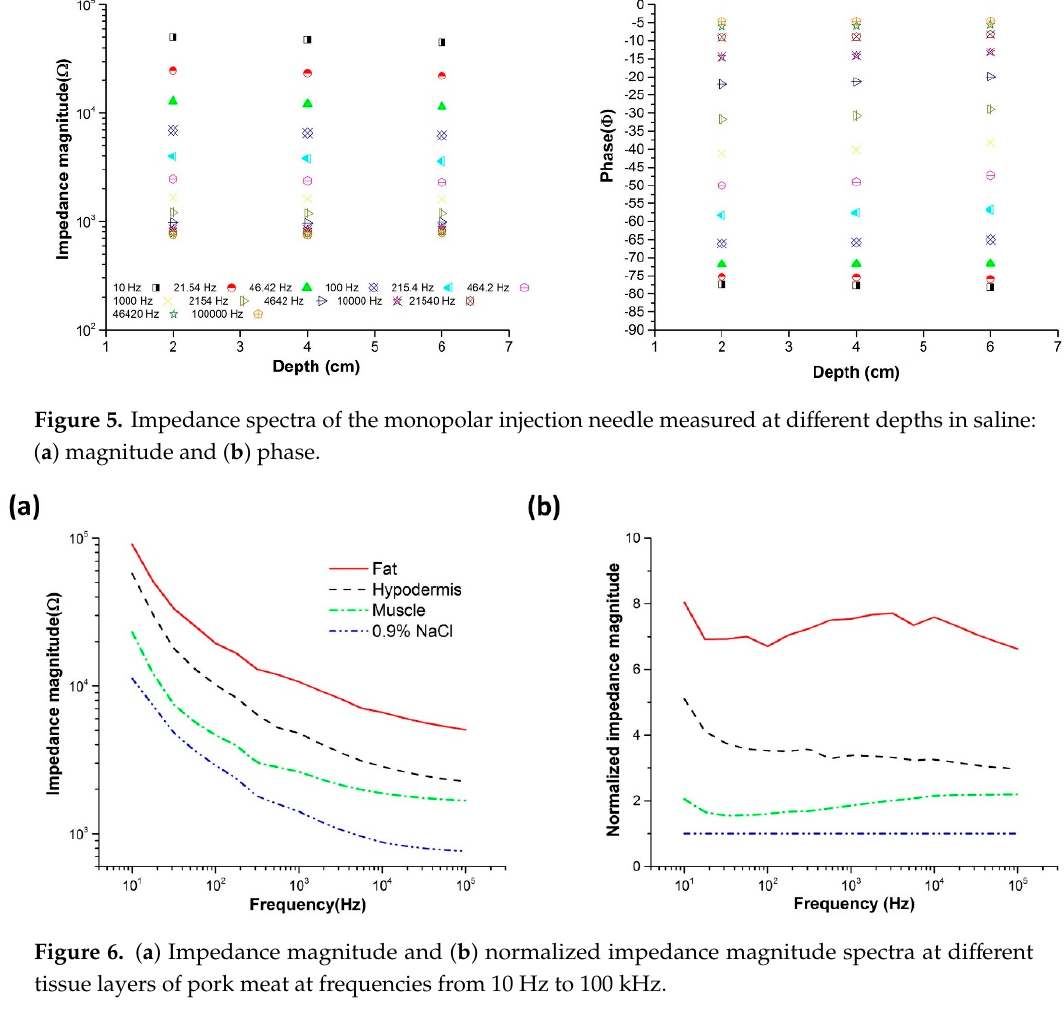
Figure 5. Impedance spectra of the monopolar injection needle measured at different depths in saline: ( a ) magnitude and ( b ) phase.